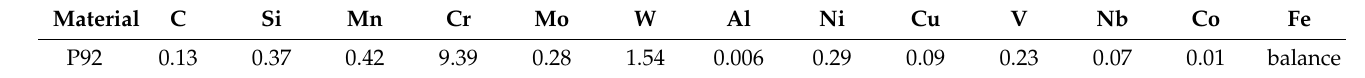
Table 1. Chemical composition (wt.%) of the investigated